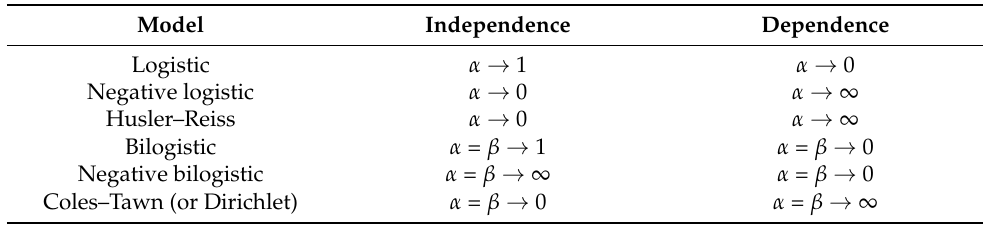
Table 2. The strength of dependence. Model Independence Dependence Logistic α → 1 α → 0 Negative logistic α → 0 α → ∞ Husler–Reiss α → 0 α → ∞ Bilogistic α = β → 1 α = β → 0 Negative bilogistic α = β → ∞ Coles–Tawn (or